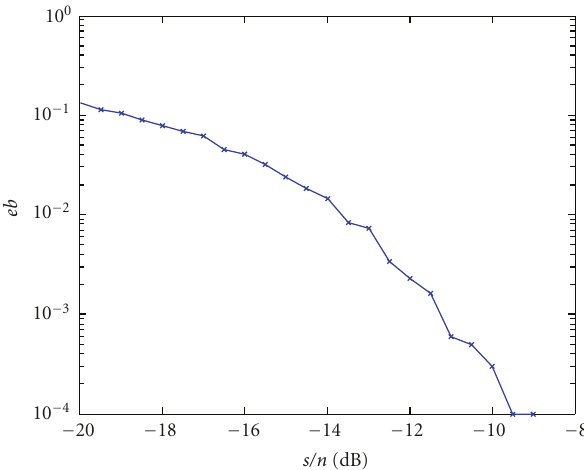
Figure 8: BER curve on the basis of precise distance